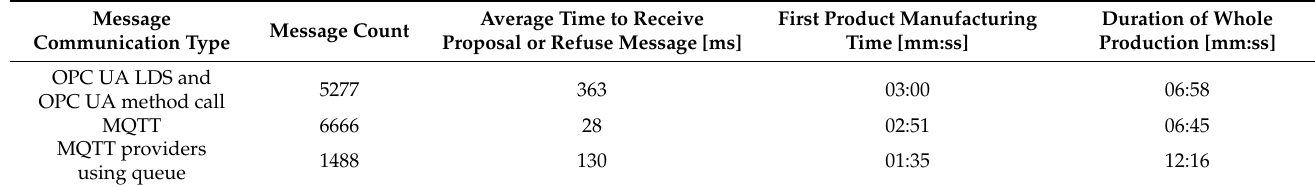
Table 3. The communication statistics.